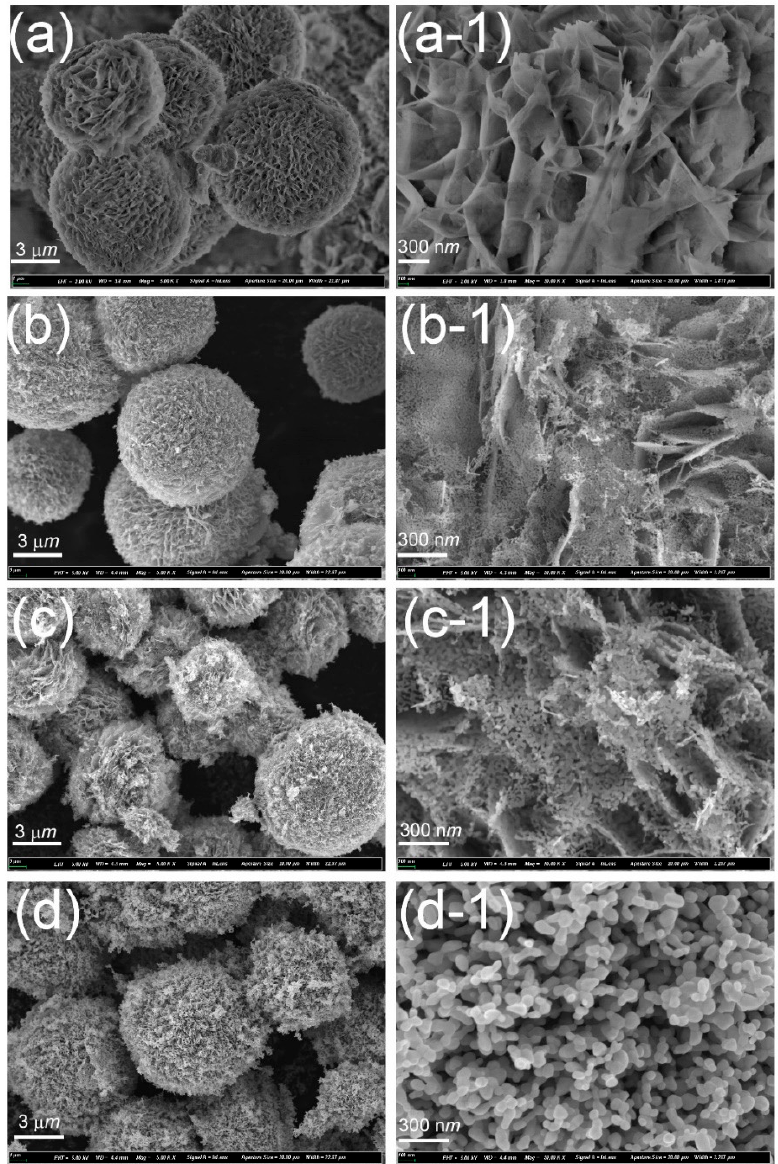
Figure 3. SEM images of the hierarchical ZnO microspheres prepared at ( a ) RT and annealed at ( b ) 300, ( c ) 400, and ( d ) 500 °C. ( a-1 ), ( b-1 ), ( c-1 ), and ( d-1 ) show the corresponding high-resolution SEM images.